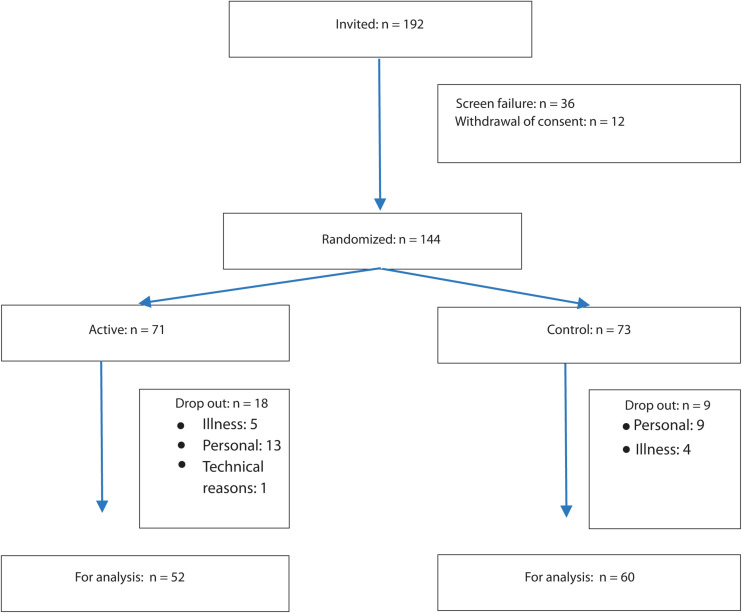
Consort diagram.